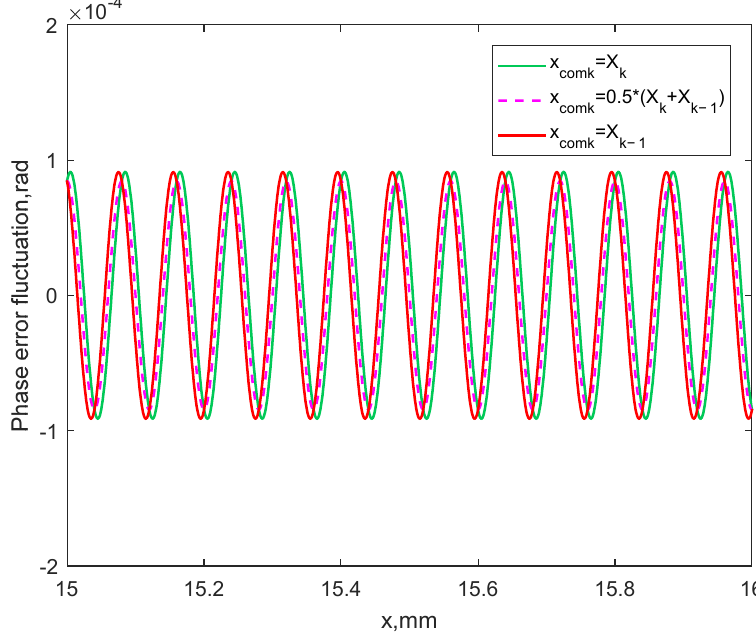
Figure 5. Phase error fluctuation under the condition of f k = g ( X k ) with different δ k . Table 1. g p (x) under the condition of f k = g ( X k ) and phase compensation with δ k . g p ( x )